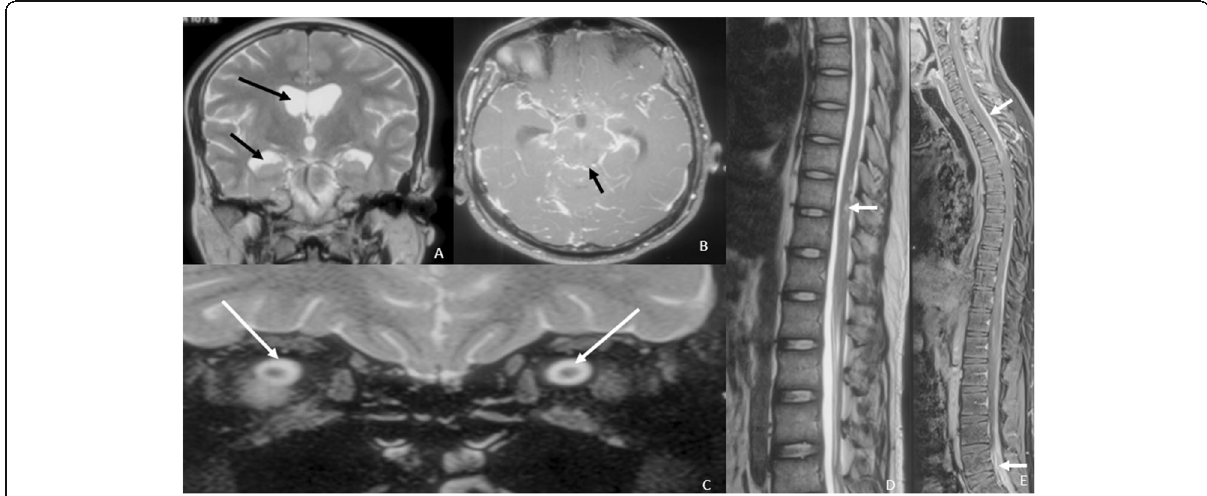
Fig. 1 Magnetic resonance imaging of the brain and dorsal spine at 2 months following the onset of symptoms. A T2W coronal image of the brain at the level of the foramen of Monro shows dilated bilateral lateral ventricles. The black arrows point to the dilated frontal and temporal horn of the right lateral ventricle. B T1W post-contrast image of the brain at the level of the mid-brain shows diffuse and thin leptomeningeal enhancement. The black arrow is pointing towards the leptomeningeal enhancement along the quadrigeminal cistern. C T2W coronal image of the brain at the level of the orbits (zoomed to demonstrate optic nerves) shows distended per-optic CSF spaces. The white arrows point towards the distended peri-optic CSF spaces. D Sagittal T2W MRI of the dorsal spine shows few cysts along the dorsal spinal cord. The white arrows point towards the intramedullary cysts within the dorsal cord. E Post-contrast T1W sagittal image of the spine. There is diffuse leptomeningeal enhancement noted along the cord surface and the nerve roots of cauda equina. The white arrows point towards the leptomeningeal enhancement along the dorsal cord and also the cauda